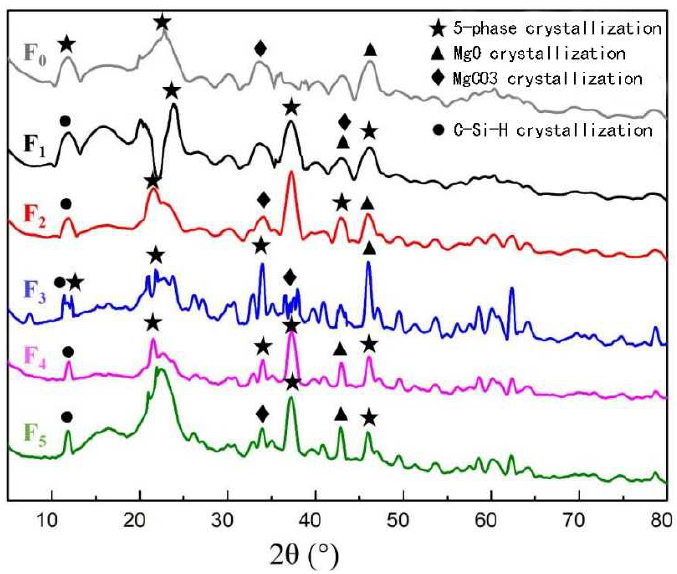
Figure 7. XRD of MOPB with different FA additions. FA addition: F 0 = 0 wt%, F 1 = 5 wt%, F 2 = 15 wt%, F 3 = 20 wt%, F 4 = 25 wt%, F 5 = 35 wt%.